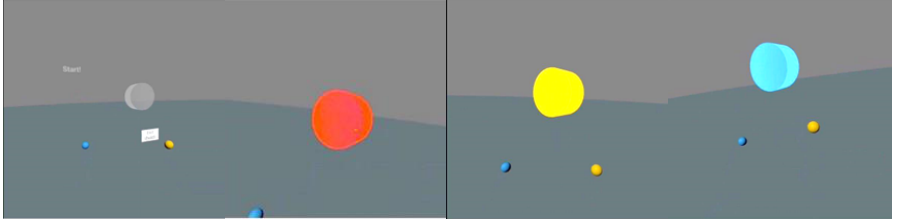
Figure 4. User view of the test — complex reaction in VR (gray — waiting for the stimulus, red — no reaction, yellow — right hand reaction, blue — left hand reaction).